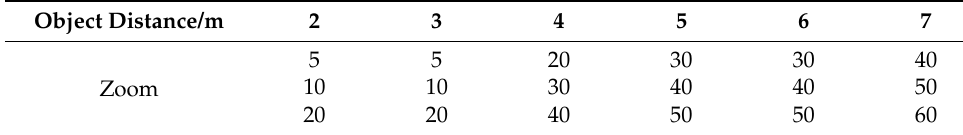
Table 1. The object distance and zoom used in the test. Object